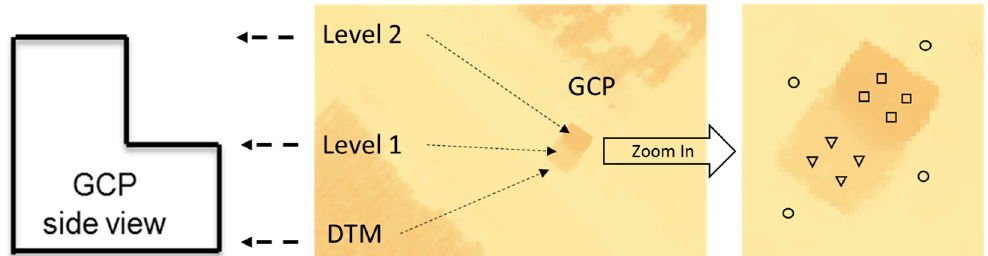
Figure 9. Height calibration using the developed multi-level GCPs in the generated digital surface model (DTM: circles, GCP level 1: triangles, GCP level 2: rectangles).